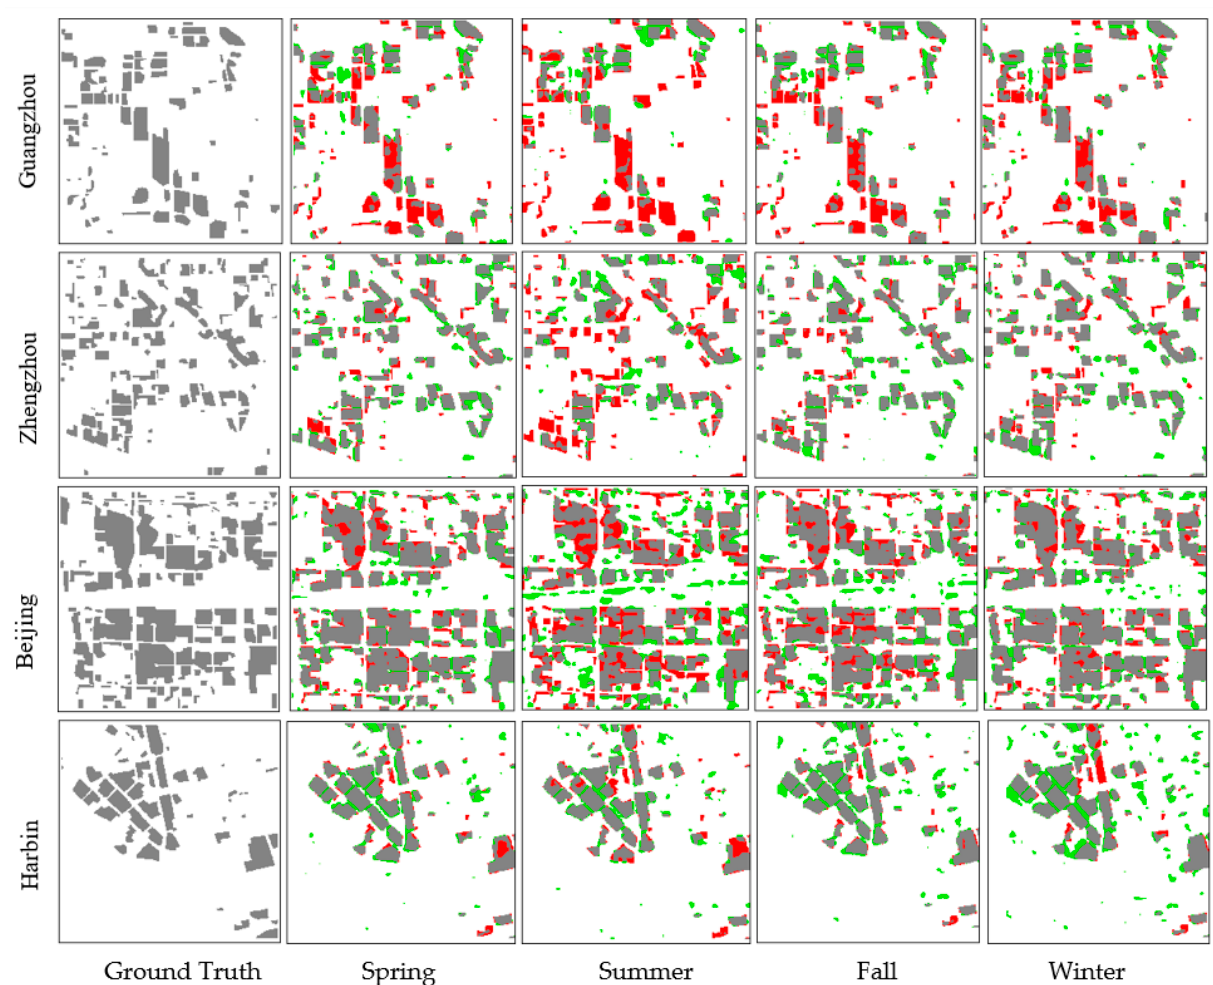
Figure 8. Ground truths and predicted HRBs in test1 in four regions in four seasons by FCN models trained on seasonally combined samples. Gray refers to true HRBs, red refer to omission errors, and green refer to commission errors.